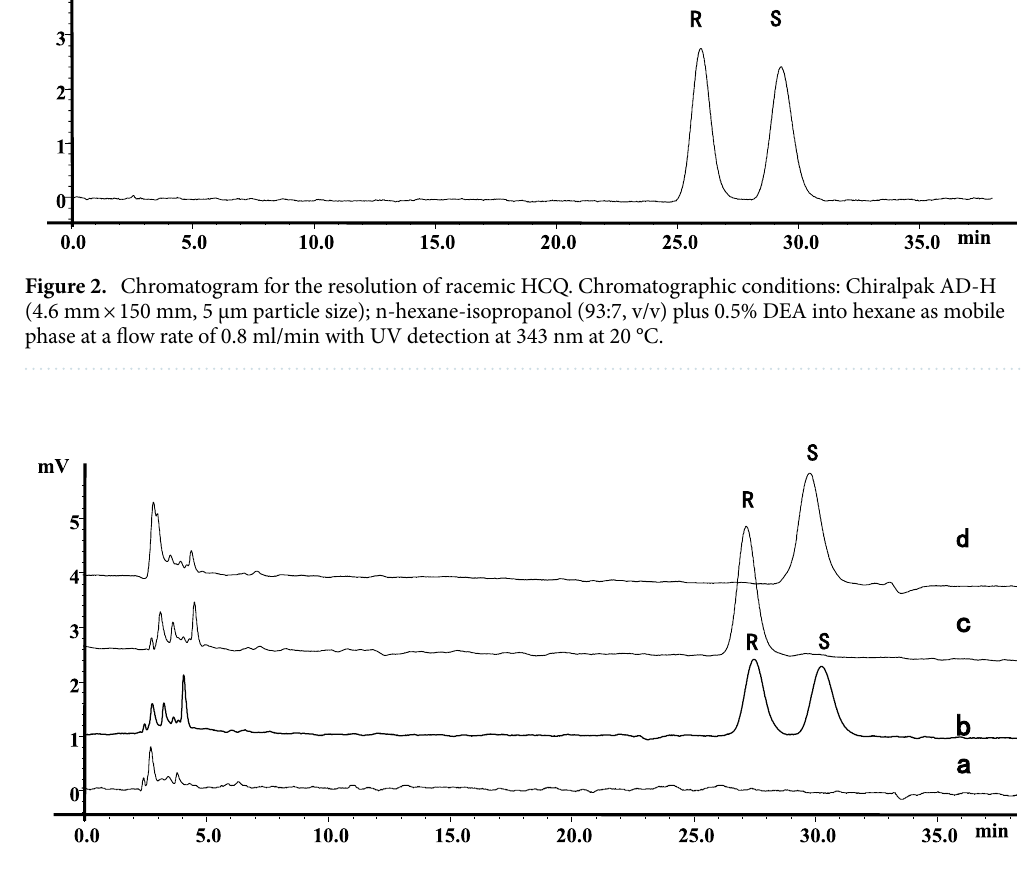
Figure 3. Comparison of chromatograms of blank rat plasma and samples incubated with rat plasma. Same analytical conditions were used as Fig. 1. ( a ) Blank; ( b ) 15 μg/ml of Rac-HCQ-sulfate incubated with rat